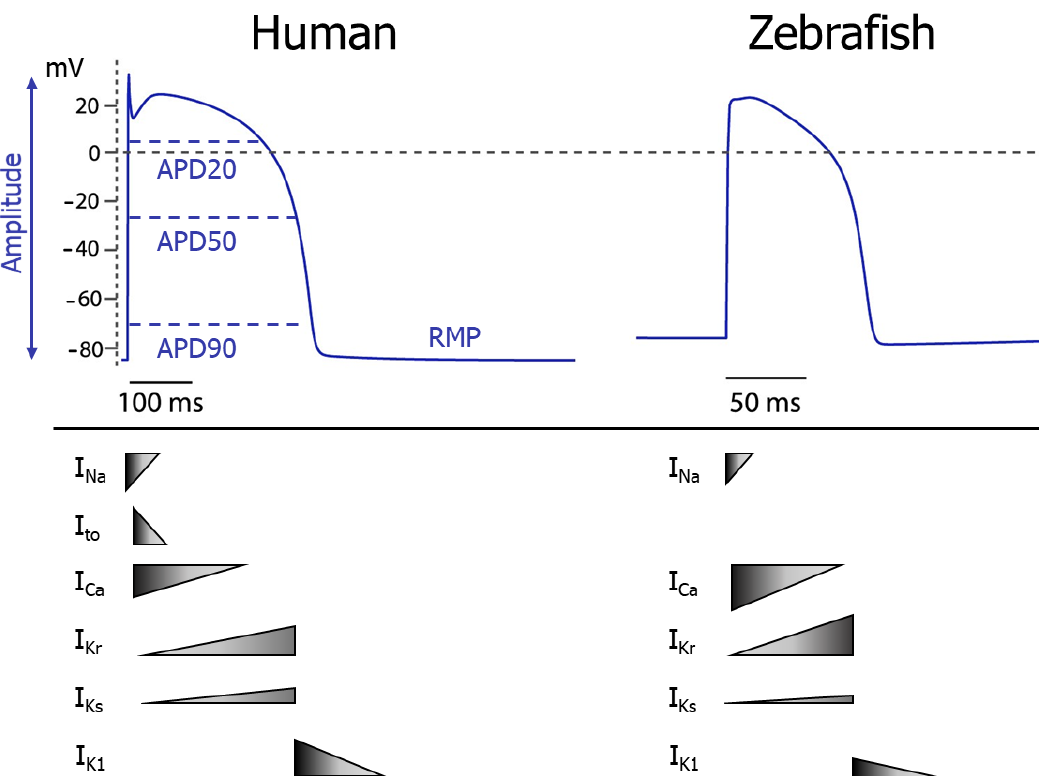
Figure 1. Comparison between human and zebrafish ventricular action potential. At the top, the ventricular action potential shape is depicted in both human and zebrafish. The bottom shows the relative magnitude of the main ion currents that contribute to the di ff erent phases of the action potential. APD20, − 50 and − 90 = action potential duration at 20, 50 or 90% repolarisation, RMP = resting membrane potential, I Na = sodium current, I to = transient outward potassium current, I Ca = calcium current, I Kr = rapidly delayed rectifier potassium current, I Ks = slow delayed rectifier potassium current, I K1 = inward rectifier potassium current. Figure adapted from Van Opbergen et al. [35].